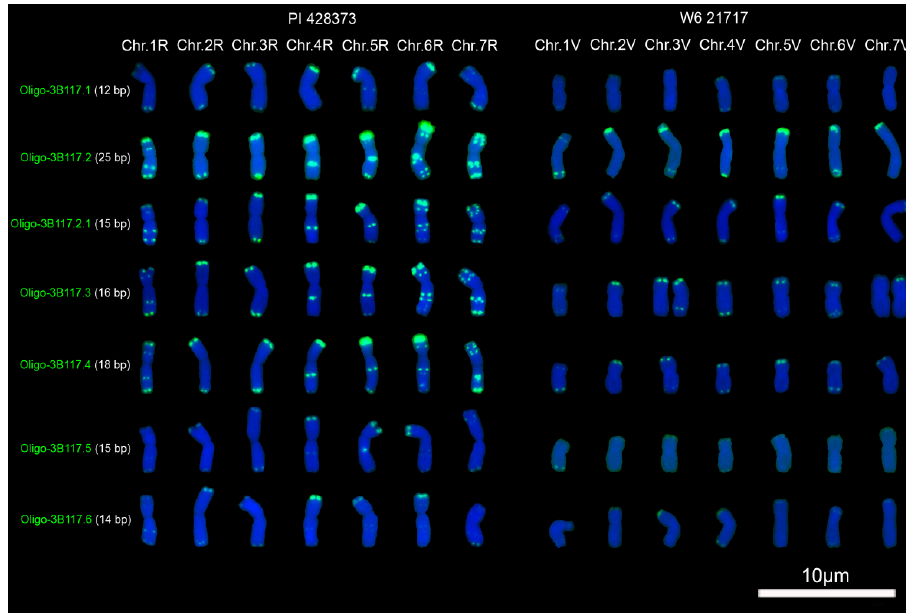
Figure 3. Signal patterns of the seven oligonucleotide probes ( green ) derived from 3B117 on the root tip metaphase chromosomes of rye PI 428373 and D. villosum W6 21717. Chr.: chromosome. Chromosomes were counterstained with 4 ′ ,6-diamidino-2-phenylindole (DAPI) ( blue ). Scale bar: 10 μ m.